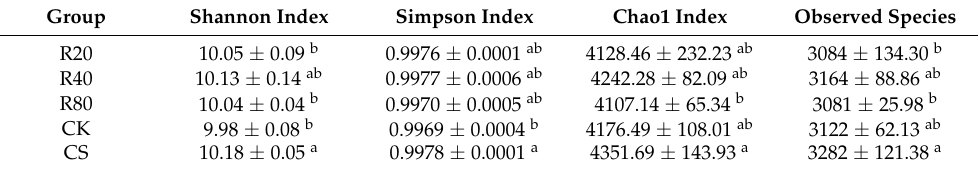
Table 3. Alpha diversity indices of soil bacterial communities under different treatments.